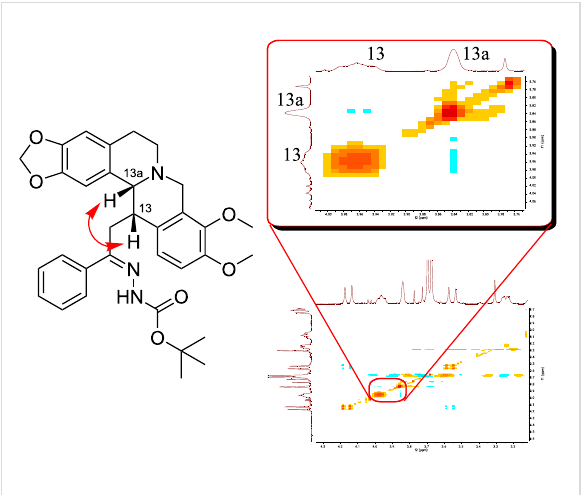
Figure 4: NOE correlation between C13 − H and C13a − H of THBER 3a .